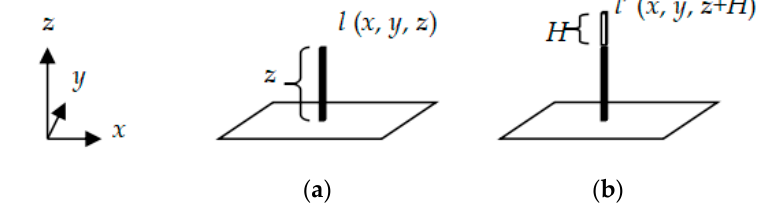
Figure 2. Terrain elevation ( a ) and viewpoint height ( b ). Figure 3. ISPRS Int. J. Geo-Inf. 2019 , 8 , x FOR PEER REVIEW